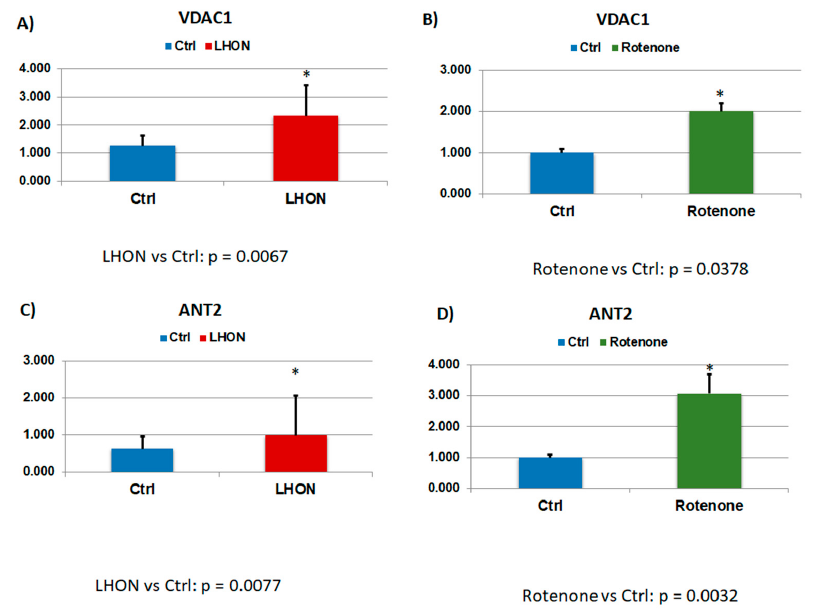
Figure 6. Increased level of glutathionylation in VDAC1 was observed in ( A ) LHON as compared with controls ( p = 0.0067) and ( B ) Complex I inhibition by Rotenone as compared with controls ( p = 0.0387). Increased level of glutathionylation in ANT2 was observed in ( C ) LHON as compared with controls ( p = 0.0077) and ( D ) Complex I inhibition by Rotenone as compared with controls ( p = 0.0032). Y-axis values refer to ratios of glutathionylated vs. un-glutathionylated. Statistical significance: * p <